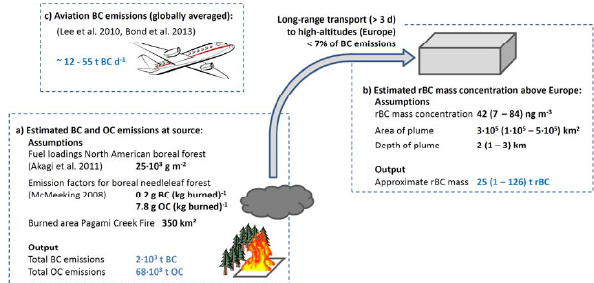
Figure 14. Schematic of the BC mass import of the Pagami Creek fire: (a) calculation of total BC and OC emissions from the fire based on fuel loadings, emission factors and burned area; (b) BC mass import into the UTLS region above Europe based on the dispersion of the plume and measured rBC mass concentrations as a best guess (and total range); (c) comparison to daily BC emissions of global aviation.